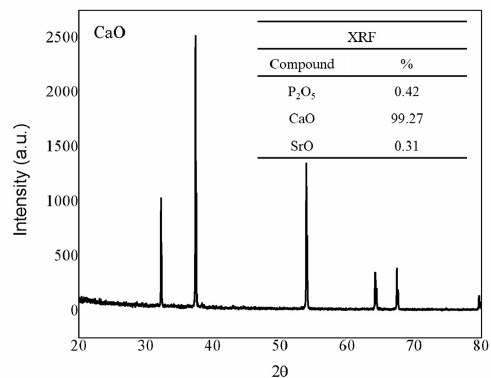
Figure 1. XRD pattern and XRF results for CaO obtained after calcination of eggshells.